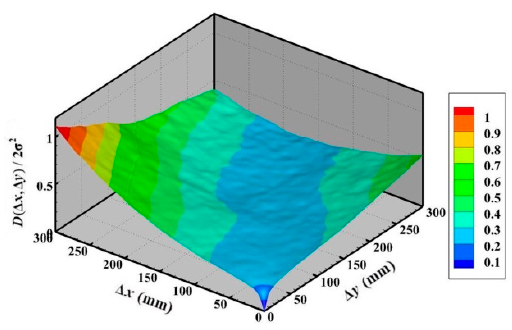
Figure 6. The second-order structure function plot of initial bed materials.